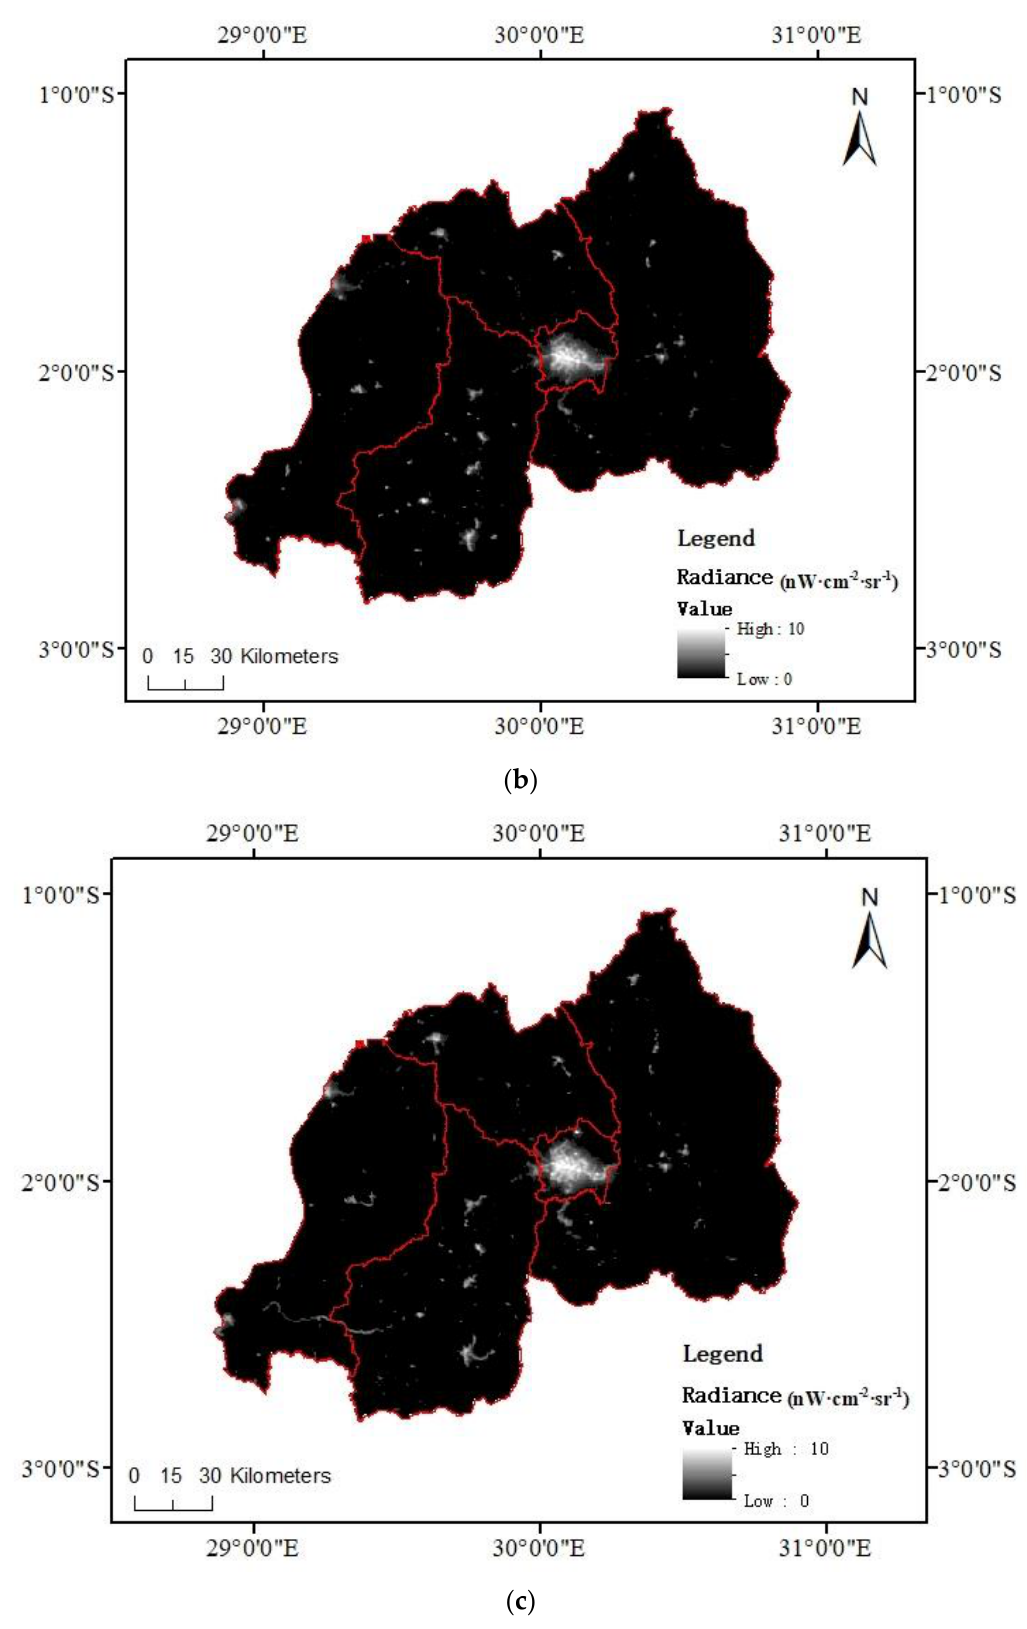
Figure 2. The nighttime light composite imagery of Rwanda: ( a ) 2012; ( b ) 2016; ( c ) 2020.